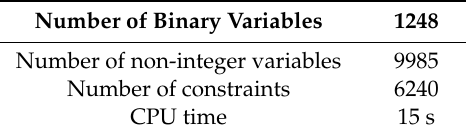
Table 2. Statistics of the optimization problem as well as the central processing unit (CPU) time required to solve the problem.